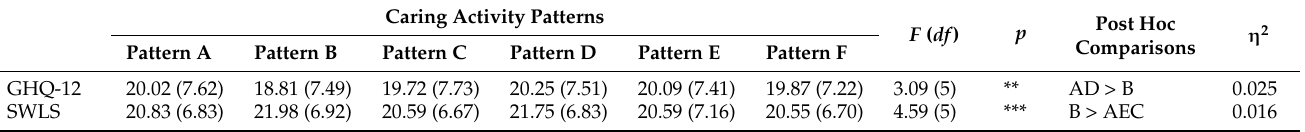
Table 4. Mental health according to caring activity